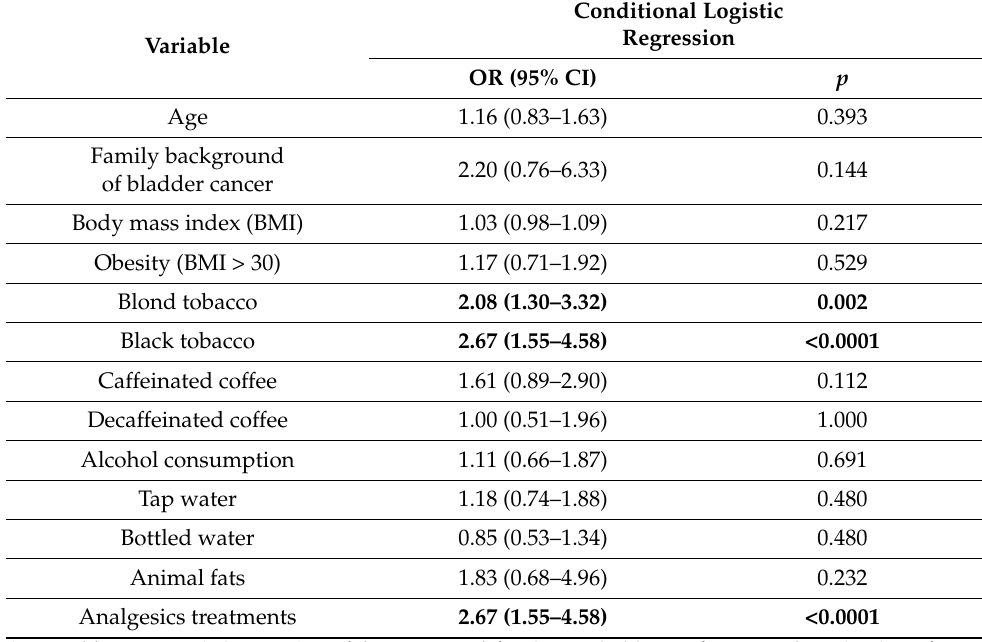
Table 2. Odds ratio and 95% CI for the risk factors